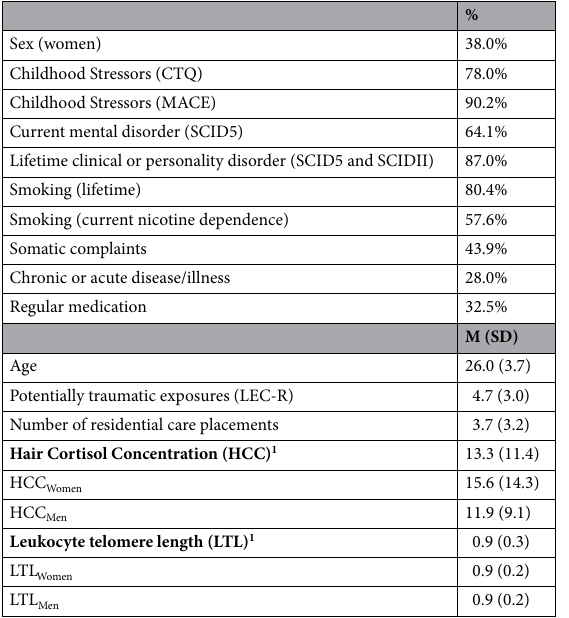
Table 1. Study descriptives (N = 92). CTQ Childhood Trauma Questionnaire, MACE Maltreatment and Abuse Chronology of Exposure Scale, SCID5 Structured Clinical Interview for Mental Disorders based in DSM5, SCIDII Structured Clinical Interview for Personality Disorders, LEC-R Life-Events Checklist revised. M=Mean; SD=Standard Deviation. 1 Wilcoxon tests for differences in HCC and LTL between men and women were non- significant.